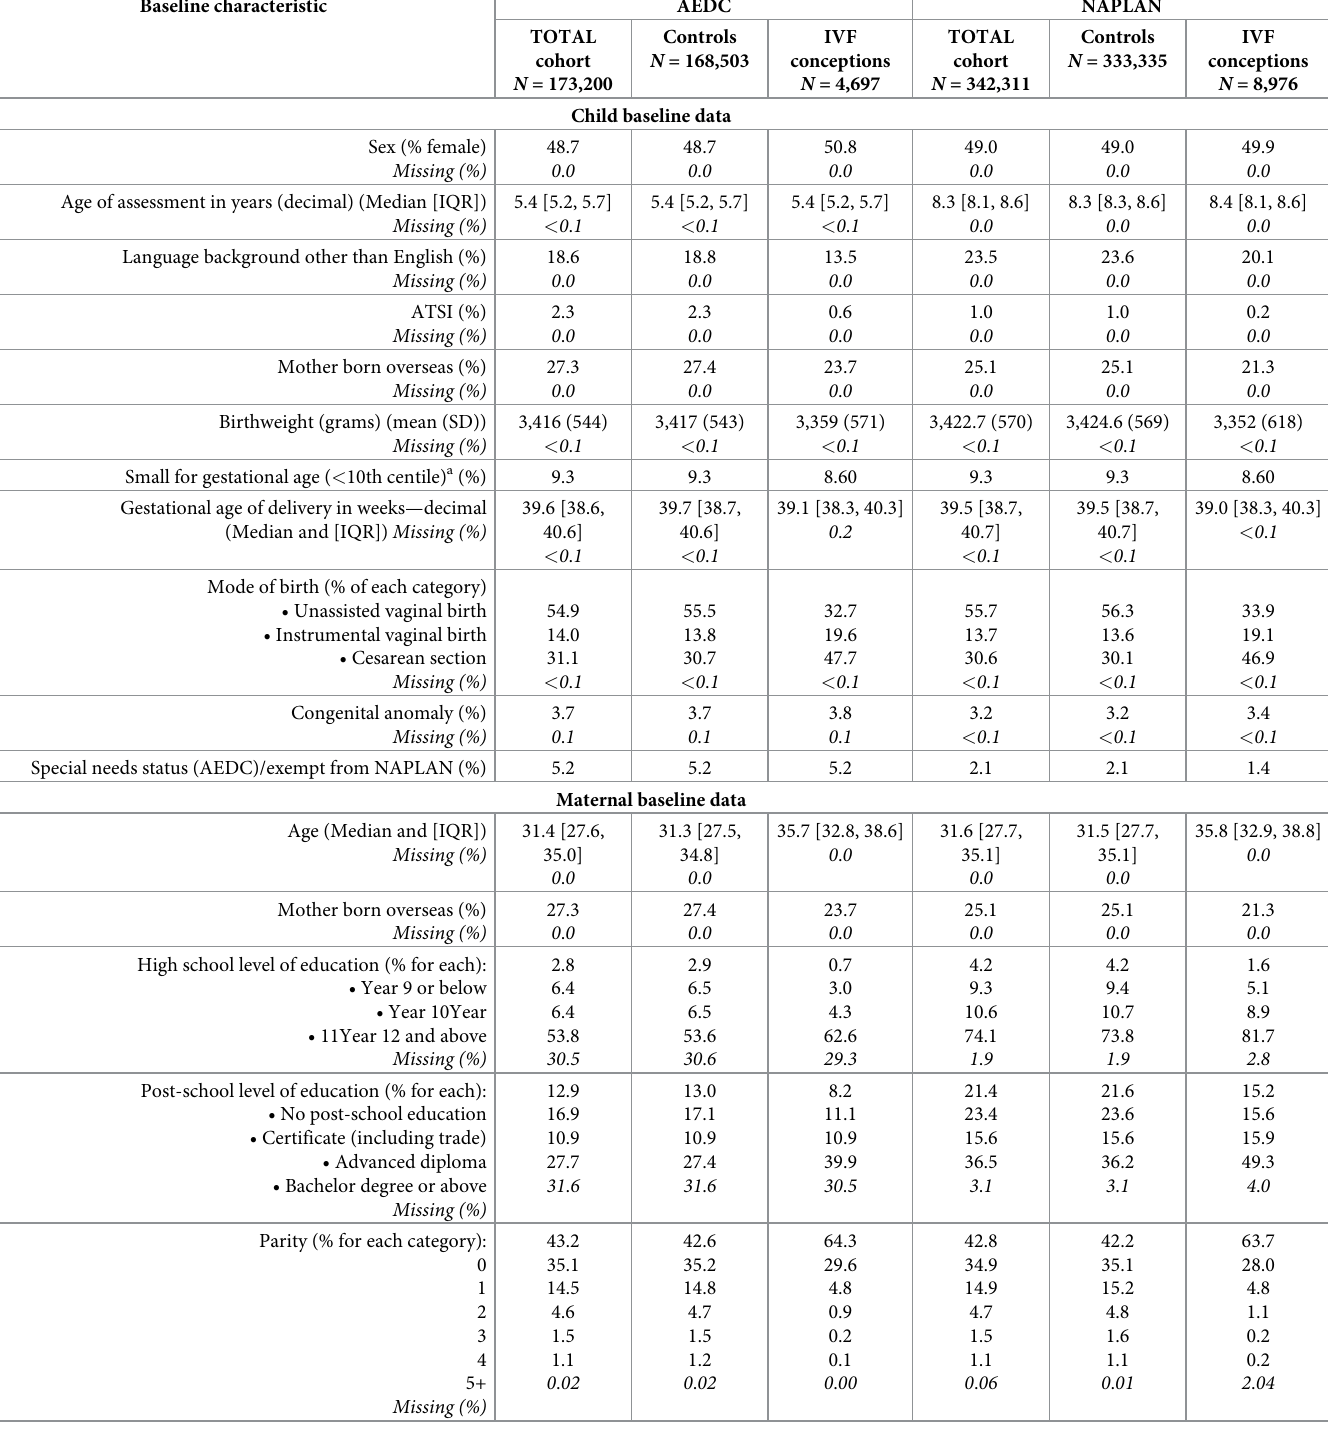
Table 2. Baseline characteristics of study cohort (including cases with missing outcome and covariate